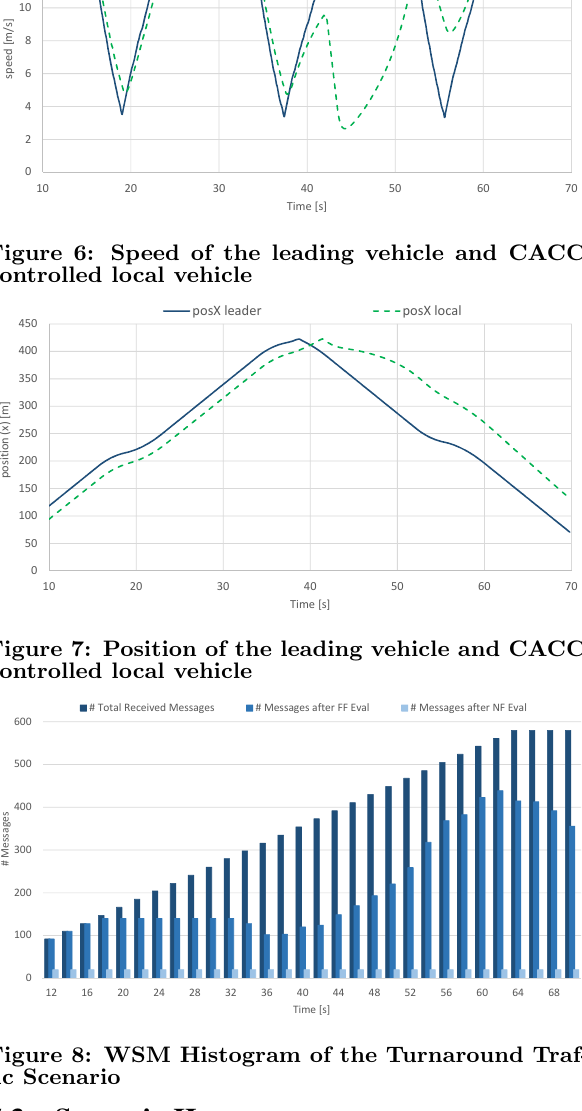
Figure 8: WSM Histogram of the Turnaround Traf- fic Scenario